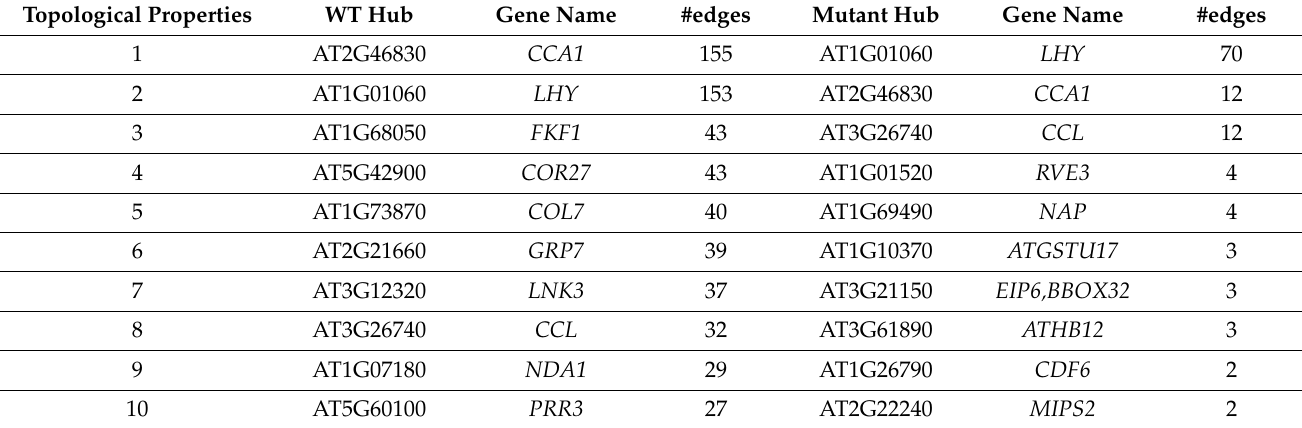
Table 2. Hub genes in wild type and mutant